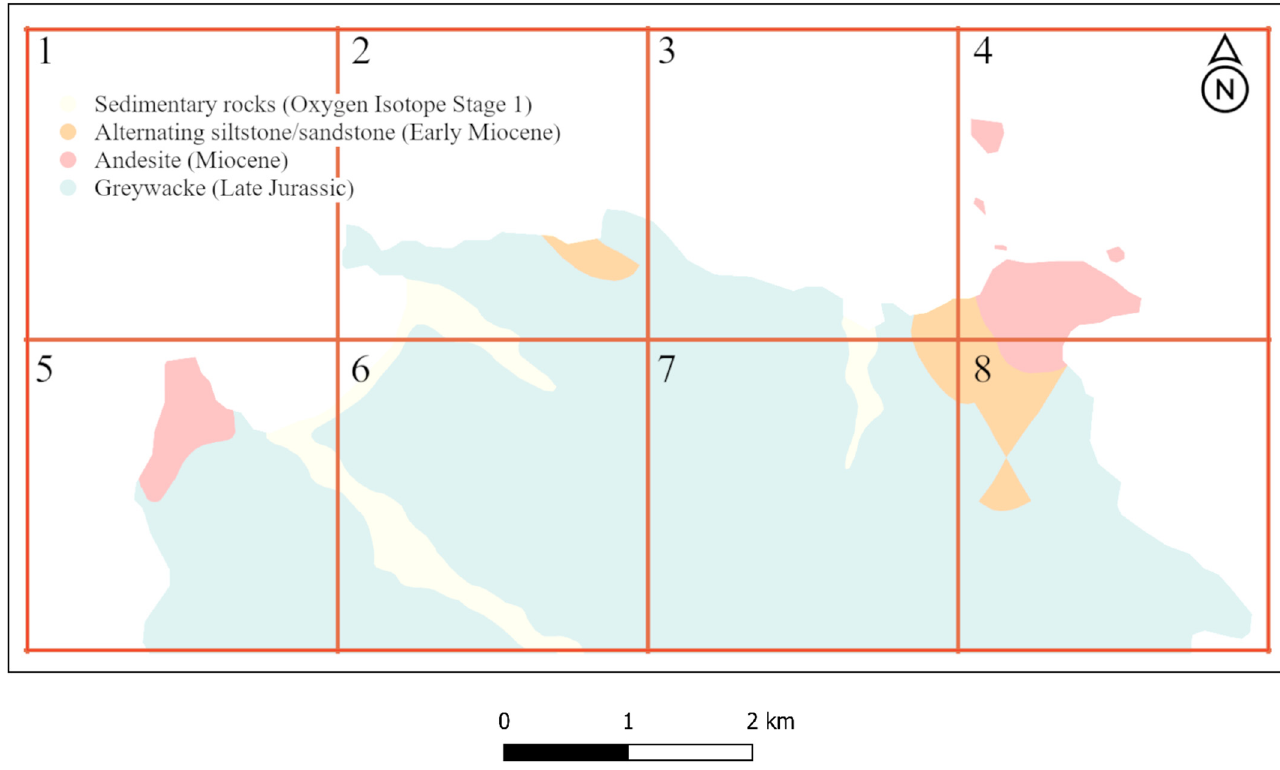
Figure 3. Detail from the Geological Qmap of Auckland area 1:250,000 [27] including the territory of Port Jackson, Fletcher Bay, and Port Charles, the north part of Coromandel Peninsula. The area of research contains 4 rock types: Quaternary Sedimentary rocks (Oxygen Isotope Stage 1), Alternating siltstone/sandstone (Early Miocene), Andesite (Miocene), and Greywacke (Late Jurassic).